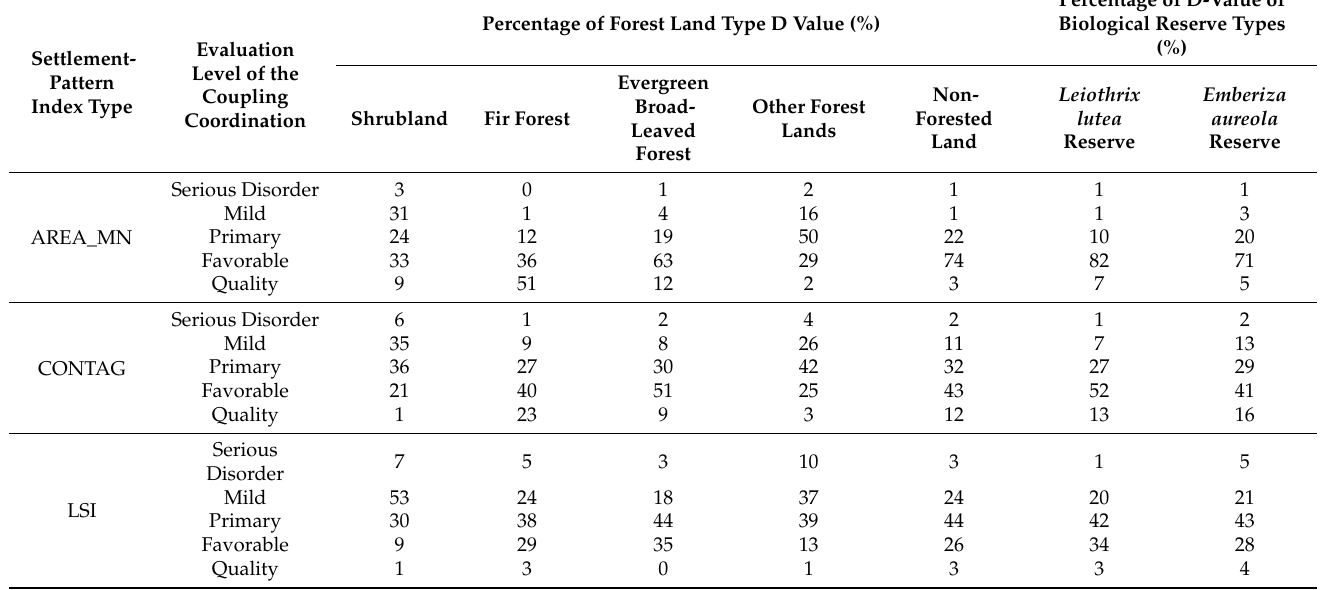
Table 7. Percentage of the number of different levels of D-values in the coupled coordination of specific types of woodlands and biological